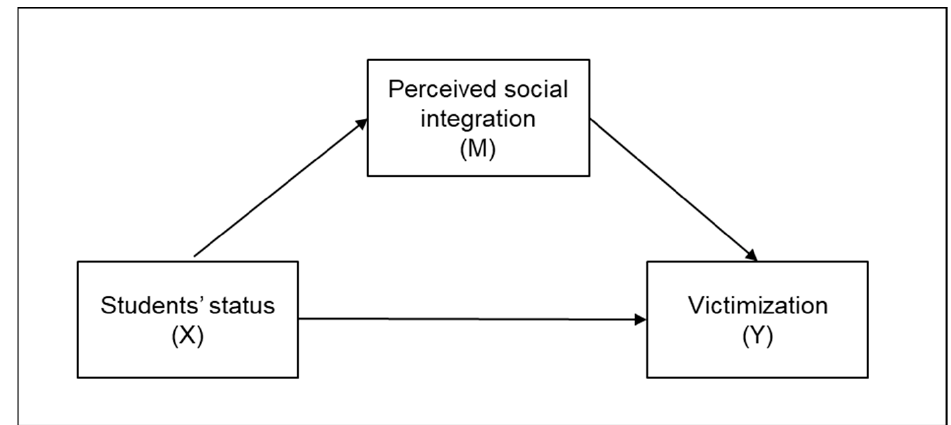
Figure 1. Research model.